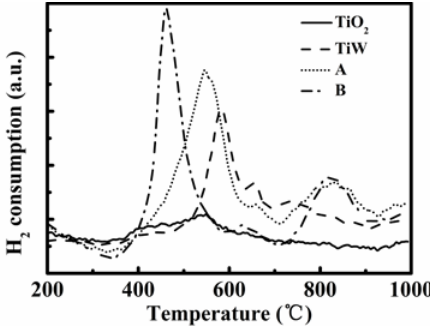
Figure 9. H 2 -TPR (temperature-programmed reduction) curves of the tested two catalysts A and B, TiO 2 support and WO 3 /TiO 2 .